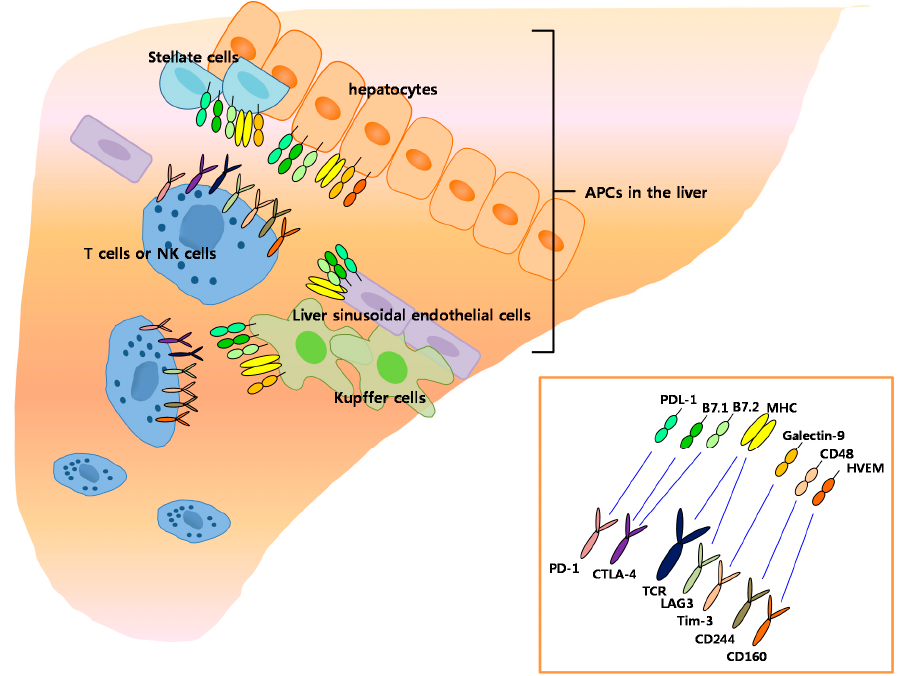
Figure 1. The interaction between immune inhibitory receptors and ligands in liver environment.